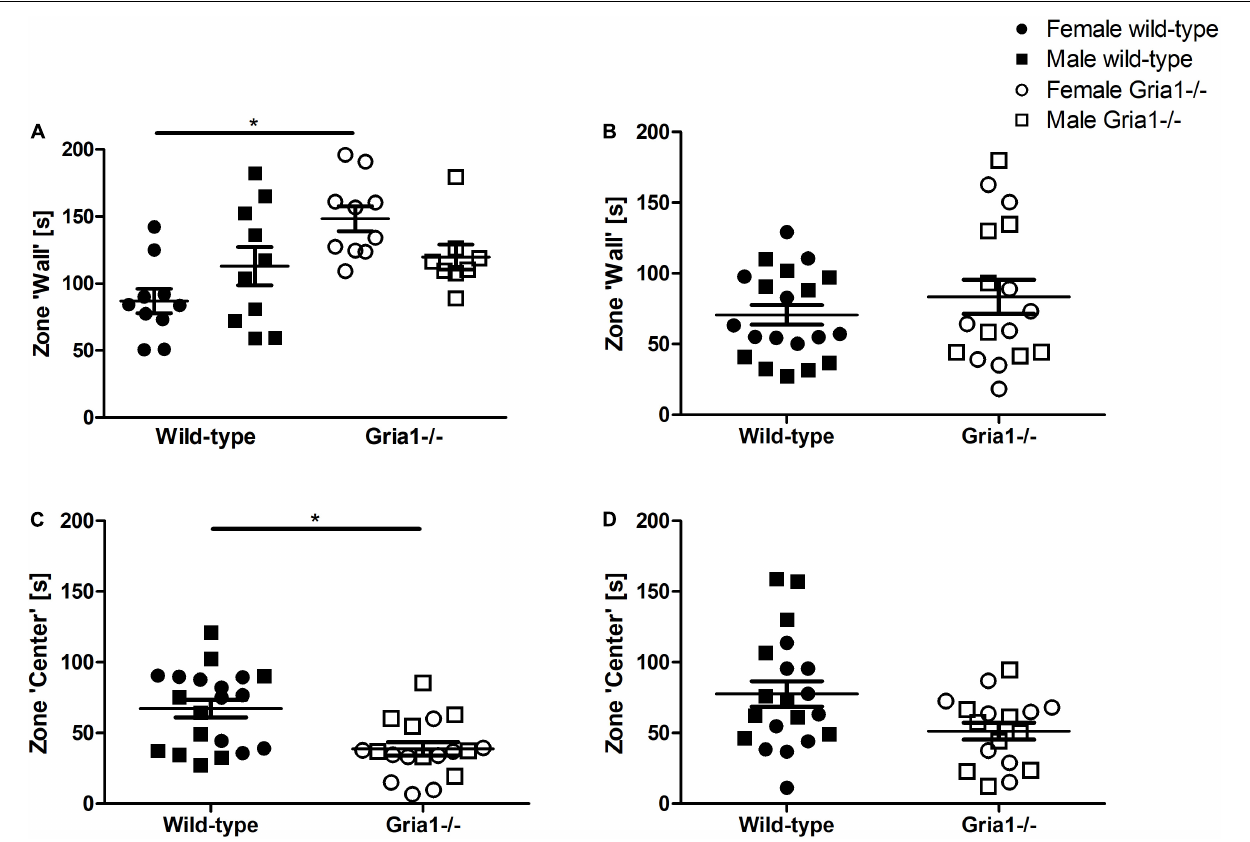
FIGURE 8 | Open field test – monitoring of the first 5 min. Analysis of the first 5 min after exposure to the open field arena revealed that there was a significant effect of genotype and a significant genotype by sex interaction in prepubescent mice indicating that female Gria1 − / − mice spent more time in the zone “wall” than female wild-type littermates (A) . In sexually mature mice, groups were statistically similar in the duration spent in the zone “wall” (B) . Considering the duration prepubescent (C) and sexually mature (D) mice spent in the zone “center” of the arena, there was a significant effect of genotype in prepubescent mice demonstrating that